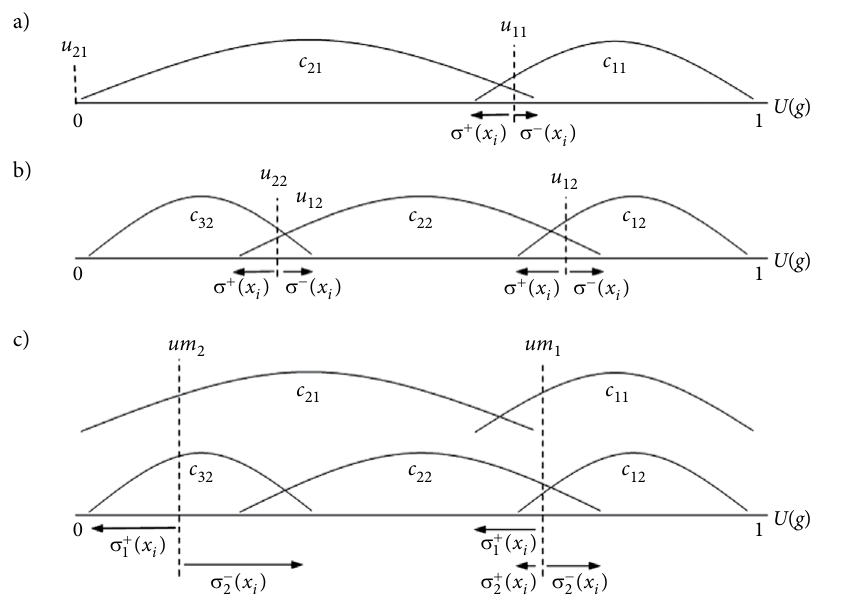
Fig. 4. Representation of misclassification errors of standard and multiple classification UtADiS methodologies for a two classification criteria with different number of